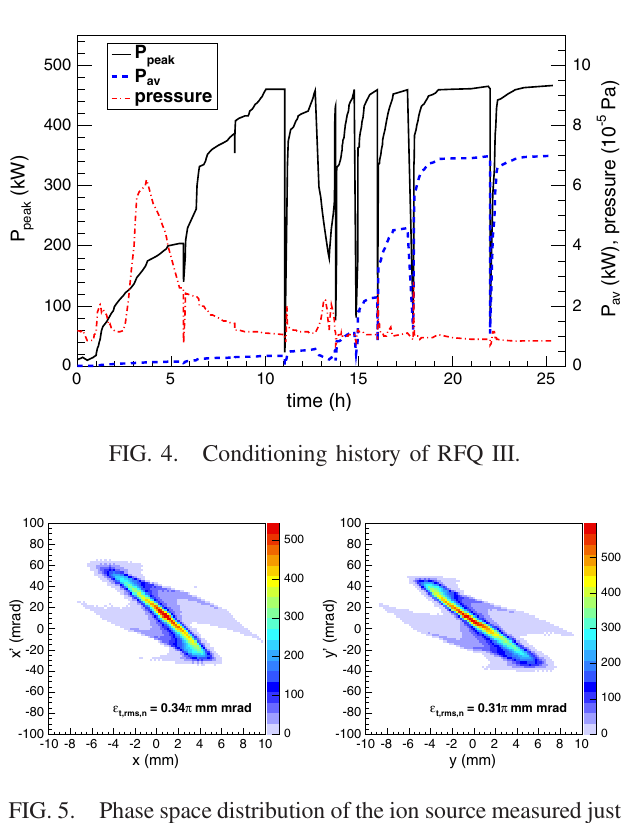
FIG. 5. Phase space distribution of the ion source measured just after the SM1 of the ion source test